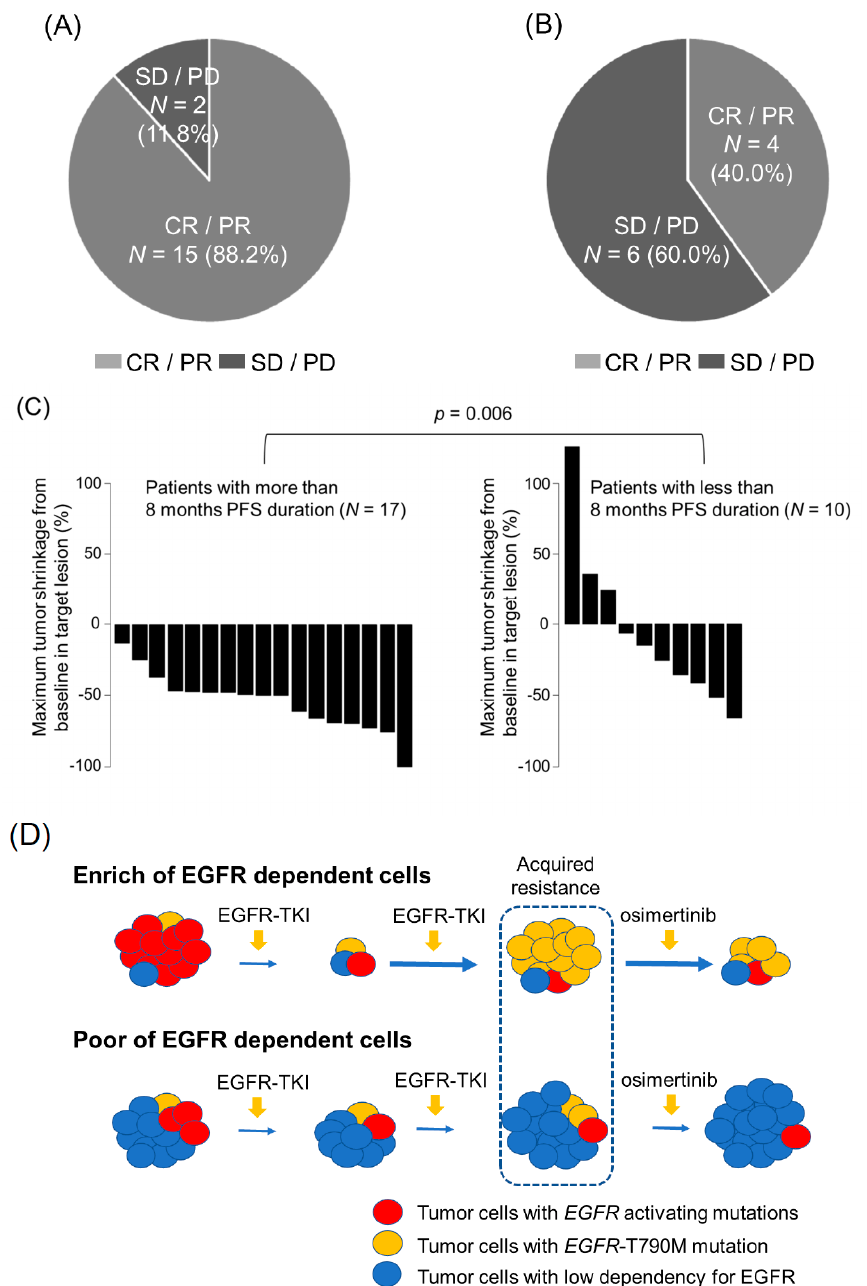
Figure 2. The osimertinib response of NSCLC patients with EGFR -T790M mutation treated with osimertinib on the PFS duration of osimertinib. ( A ) Frequency of the best overall response to osimertinib treatment among EGFR -T790M mutant NSCLC patients with the more than 8 months PFS duration ( N = 17). ( B ) Frequency of the best overall response to osimertinib treatment among EGFR -T790M-mutant NSCLC patients with the less than 8 months PFS duration ( N = 10). ( C ) The median maximum tumor shrinkage rate relative to baseline in 27 NSCLC patients with EGFR -T790M mutation treated with osimertinib. The PFS duration of 17 patients was more than 8 months and that of 10 patients was less than 8 months. The median maximum tumor shrinkage rate in these patients indicated a significant association with the osimertinib response (50.0% and 20.6%, respectively, p = 0.006). ( D ) Schematic diagram showing that tumors with resistance to EGFR-TKIs may be heterogeneous, consisting of both EGFR signal dependency with EGFR activating mutation (red) or with EGFR -T790M mutation (yellow), and EGFR signal independency (blue)